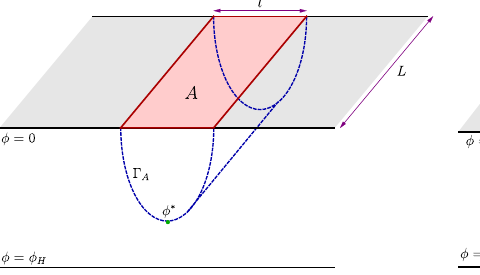
is small enough, the minimal surface of A ∪ B are given by (cid:12) l (cid:3) ∪ (cid:12) l (cid:3) + 2 l and when l (cid:3) is large enough, the minimal surface of A ∪ B are given by 2 (cid:12) l . The minimal surfaces, the dashed curves, are denoted by (cid:12)